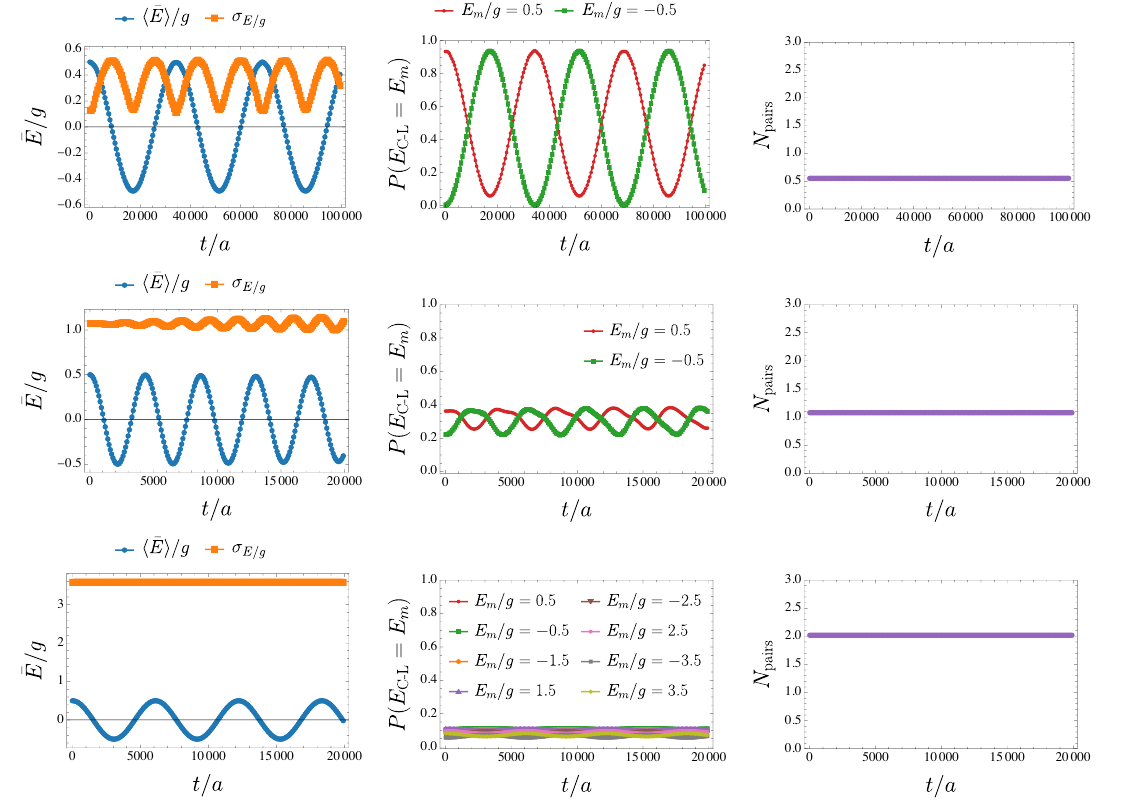
(cid:10) ¯ (cid:11) Figure 2. The expectation values of the spatially averaged electric field E /g , the standard deviation of the spatially averaged electric field σ , the probability to measure field E on the m E/g central link P ( E = E ) , and the number of electron-positron pairs N as functions of time in C-L m pairs the k = 1 quench for m = 50 , with three different spatial circle sizes mL = 8 (top panel), mL = 4 g (middle panel) and mL = 1 (bottom panel) on an N = 10 lattice. On the lattice, we set l = 10 max for mL = 8 , 4 simulations and l = 30 for mL = 1 simulation to achieve error . O (10 − 10 ) for max the lowest four energy levels E /g